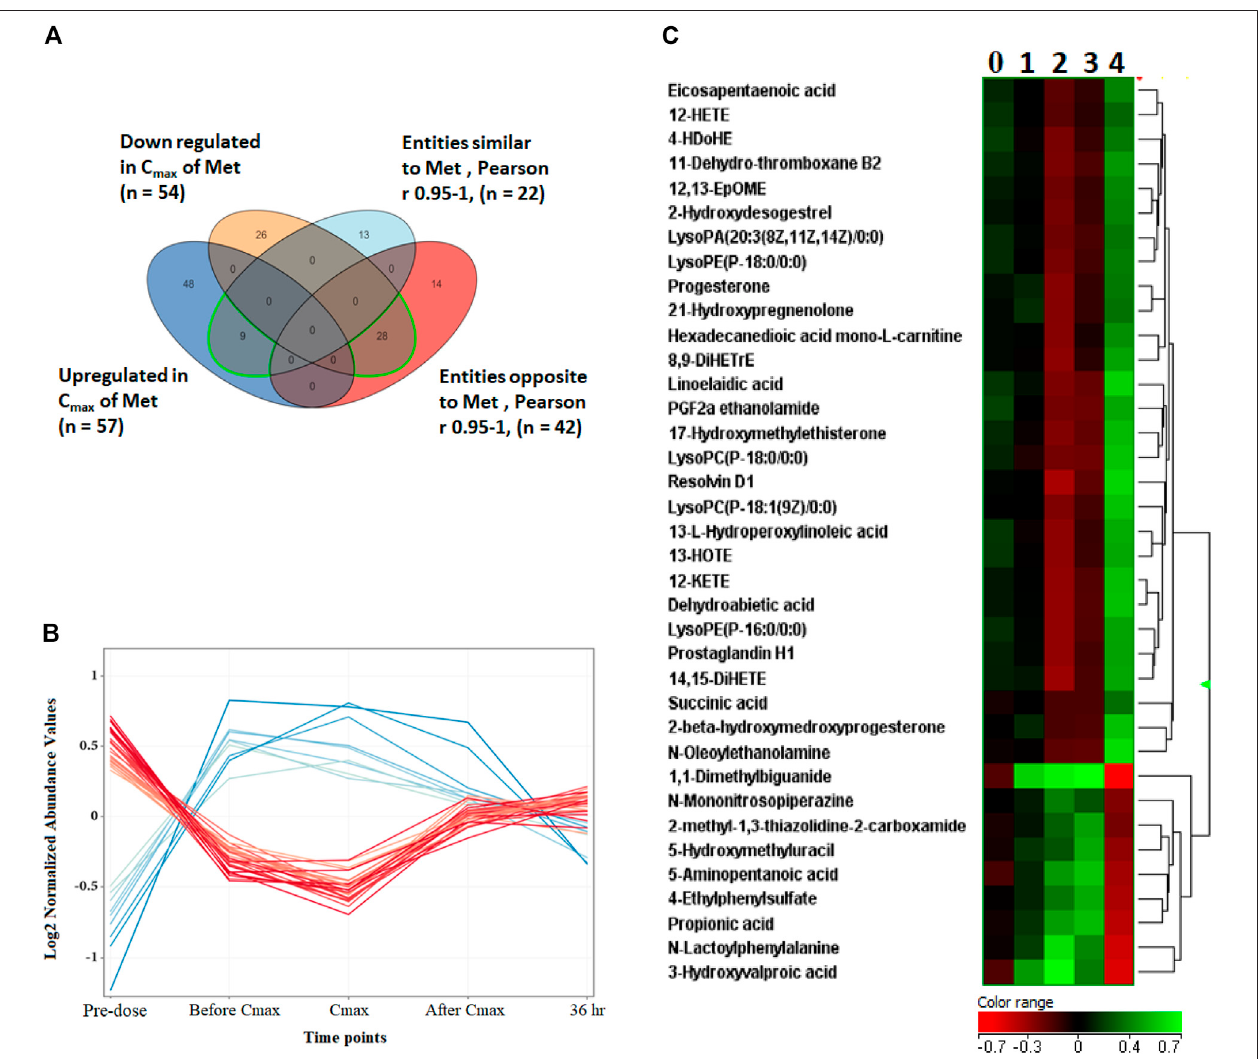
FIGURE4 | Metformin-dependent metabolites. (A) Venn diagram showing signi fi cantlyaltered metabolites and metabolites withsimilar or opposite change intheir metabolic levels compared to metformin levels at the fi ve time points based on Pearson similarity test (R0.95 – 1). (B) The 28 (red line) and 8 (blue line) metformin- dependent metabolites showing opposite and similar trend intheirlevels to metformin, respectively. (C) Hierarchalclustering(HAC) and heatmap analysis ofsigni fi cantly altered metformin dependent metabolites. Time points 0, 1, 2, 3, and 4 refer to baseline, before C max , C max , after C max and 36 h post metformin administration. Metformin is